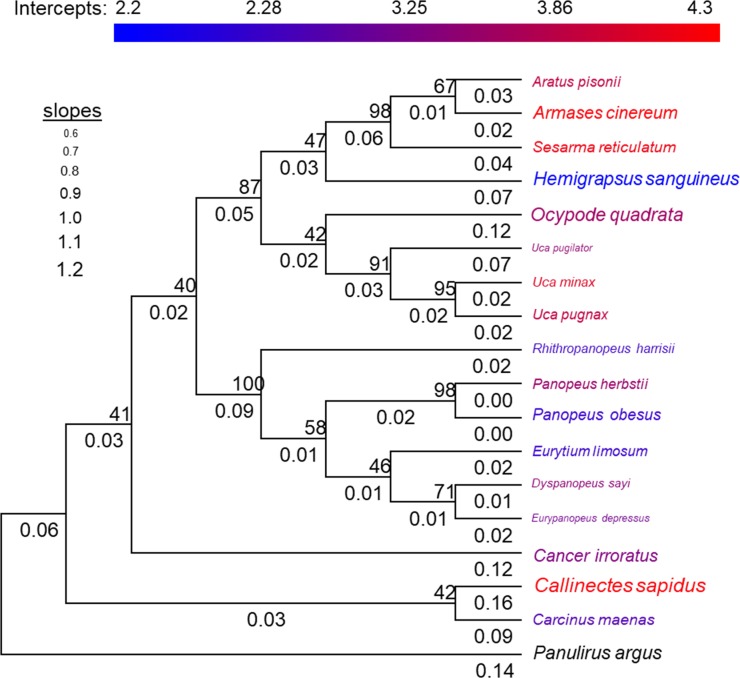
Phylogenetic relationship between crabs used in this study based on overlapping regions of 16S rRNA.The size of the text for the species name gives the slope of the allometric relationship for stomach volume vs. dry body mass (see reference values given on left-hand side of figure for numerical values of different relative sizes), while the color of the text for the species name gives the value of the intercept based on the scale bar shown above the phylogenetic tree. Decimal values given below each branch indicate the branch length, while the whole numbers next to each node indicate bootstrap percentages based on 1,000 bootstrap replicates.